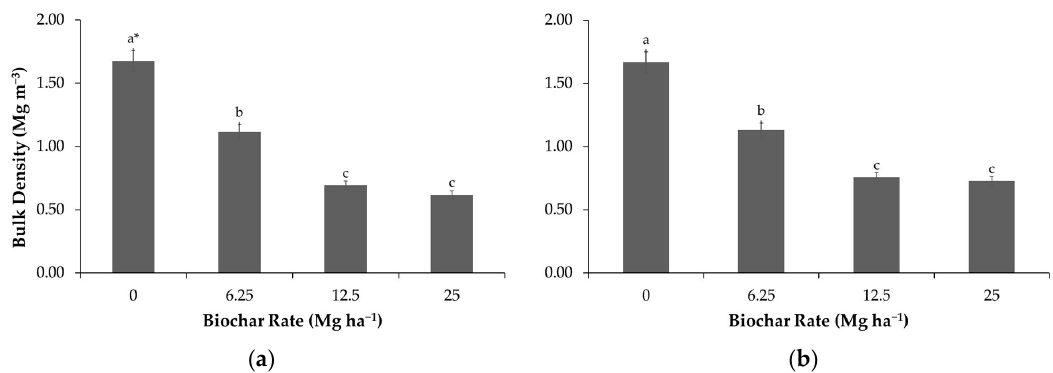
Figure 1. Soil bulk density as a function of biochar rates (0, 6.25, 12.5, and 25 Mg ha − 1 ) evaluated at ( a ) 50 days and ( b ) 150 days after incorporation in soil. * Means followed by the same letter did not differ according to Tukey’s test ( p < 0.05).